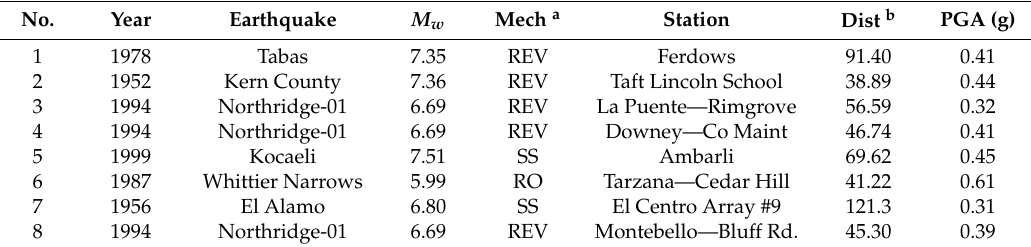
Table 3. Far field ground motion